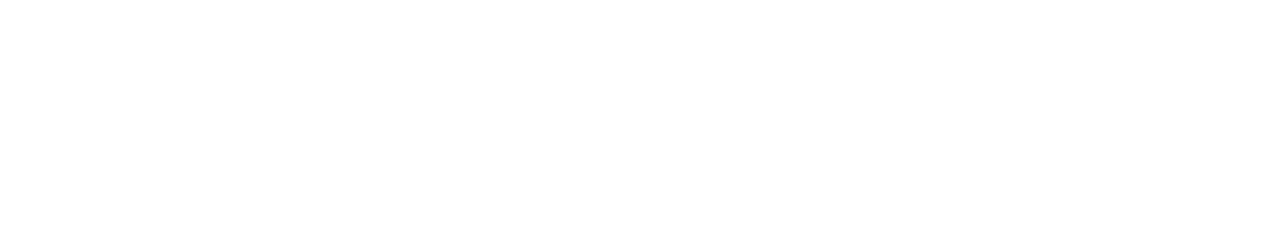
Frontiers in Integrative